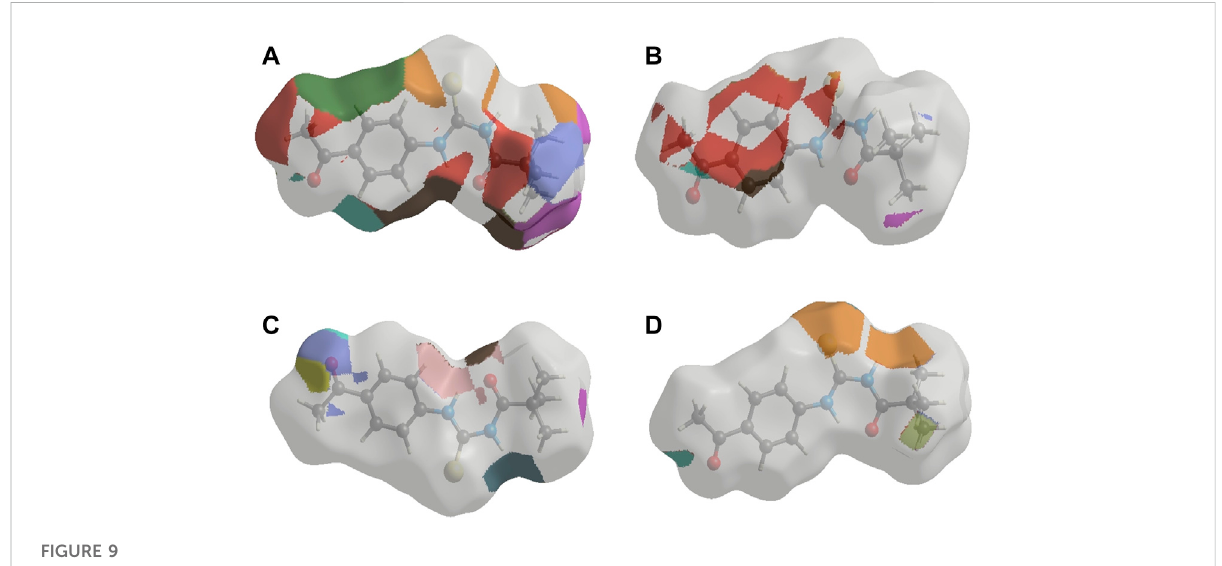
(cid:129)(cid:129)(cid:129)